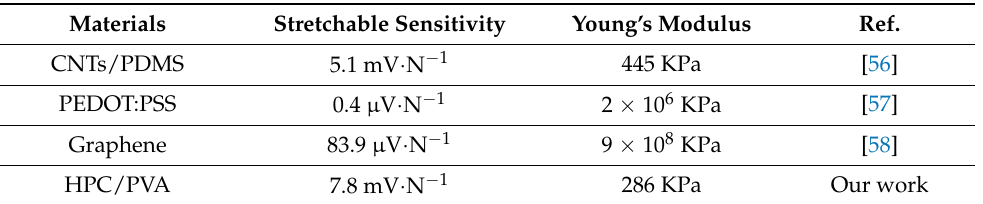
Table 1. A summary of sensor’s characterization. CNT—carbon nanotube; PEDOT:PSS—poly(3,4-